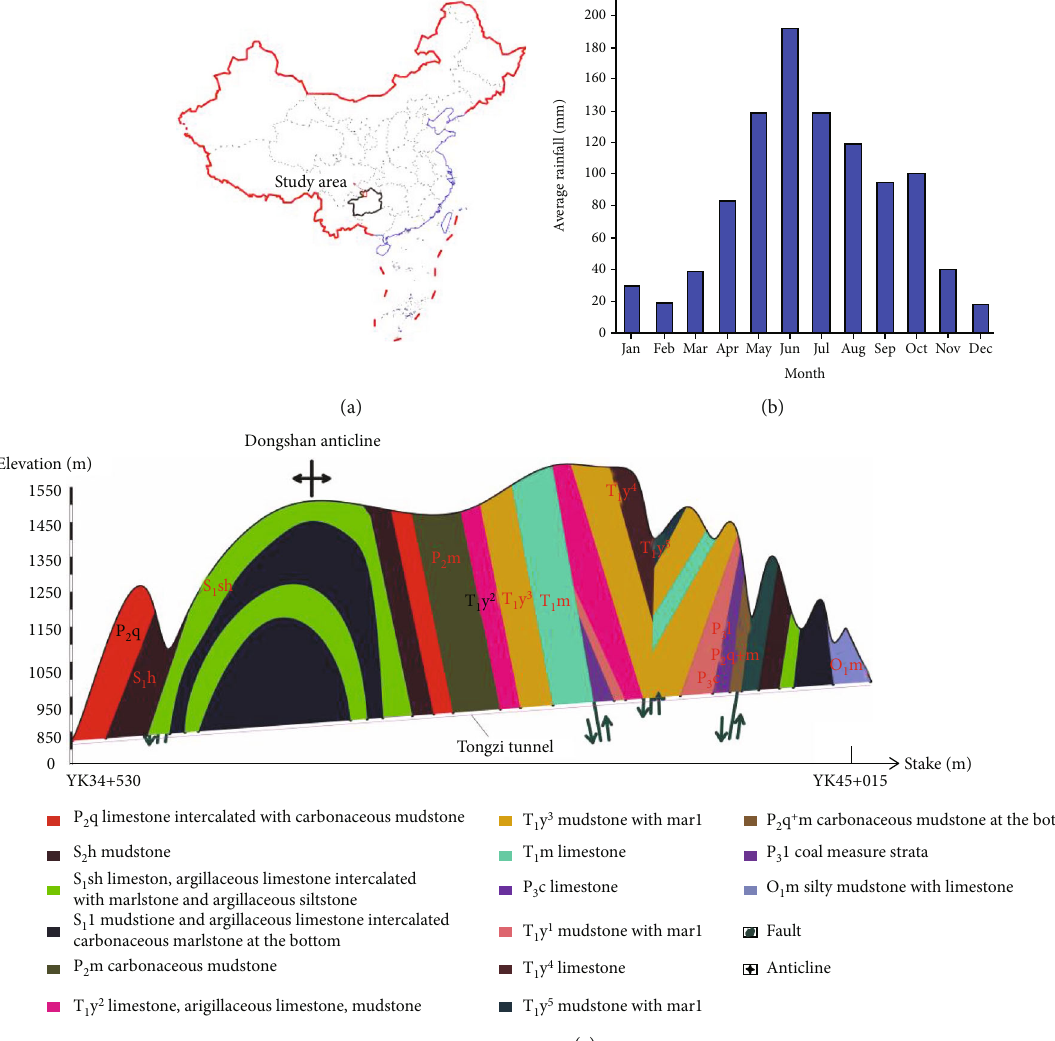
Figure 1: (a) Location of the study area. (b) Monthly average rainfall in the study area from 1995 to 2011. (c) Geological pro fi le of Tongzi